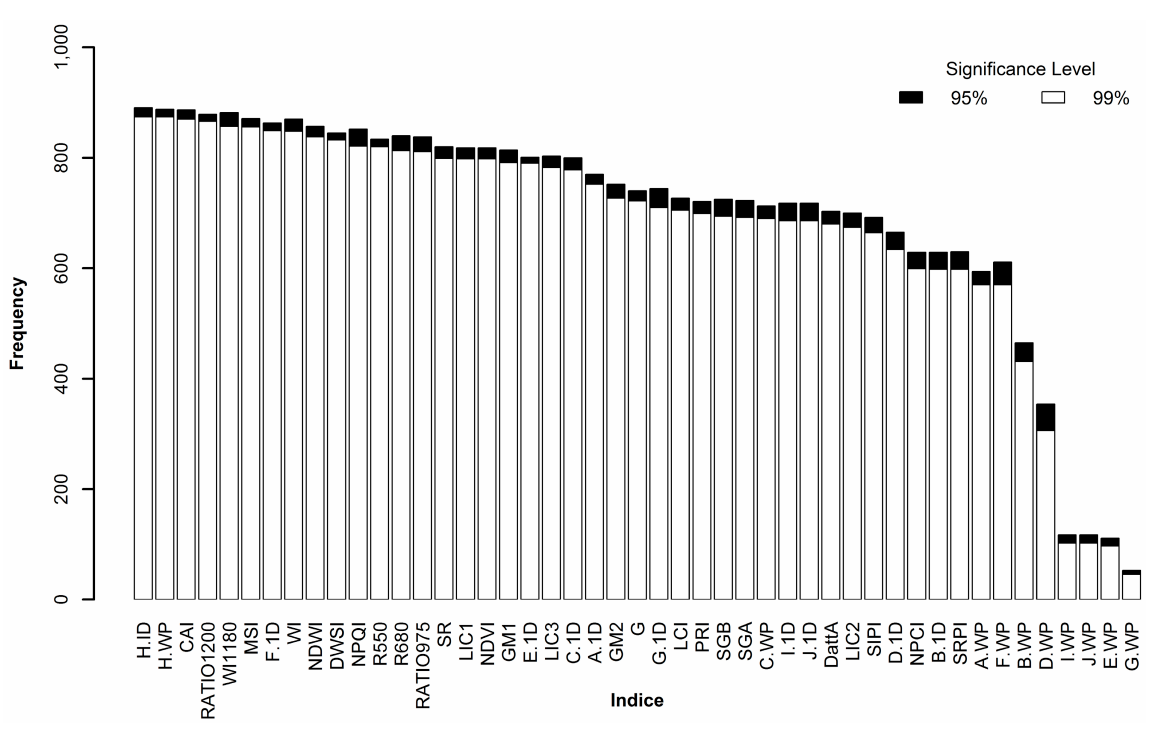
Figure 5. Frequency distribution of the Mann–Whitney U- test for the 47 spectral variables for paired species across the 46 species studied. Each bar represents the number of paired species for which a spectral variable difference is